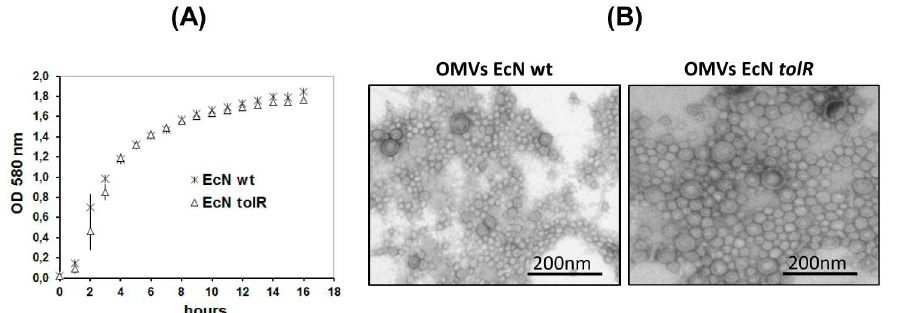
Fig 1. Effect of a tolR mutation on EcN growth and vesicle size. (A) Growth curves of wild-typeEcN (cross) and EcN tolR (triangles) cultivatedin LB medium. Valuesare means ± standarderror from three independent experiments. (B) Negativestainingelectron microscopy of MVs releasedby these strains after 15 h growth in LB. For both strains, MVs were collectedfrom a 1-litre culture and resuspended in a final volume of 0.2 ml. Representative images of MV samples from wild-typeEcN (direct inspection) and EcN tolR (1:20 dilution)are shown. Scale bars: 200 nm.